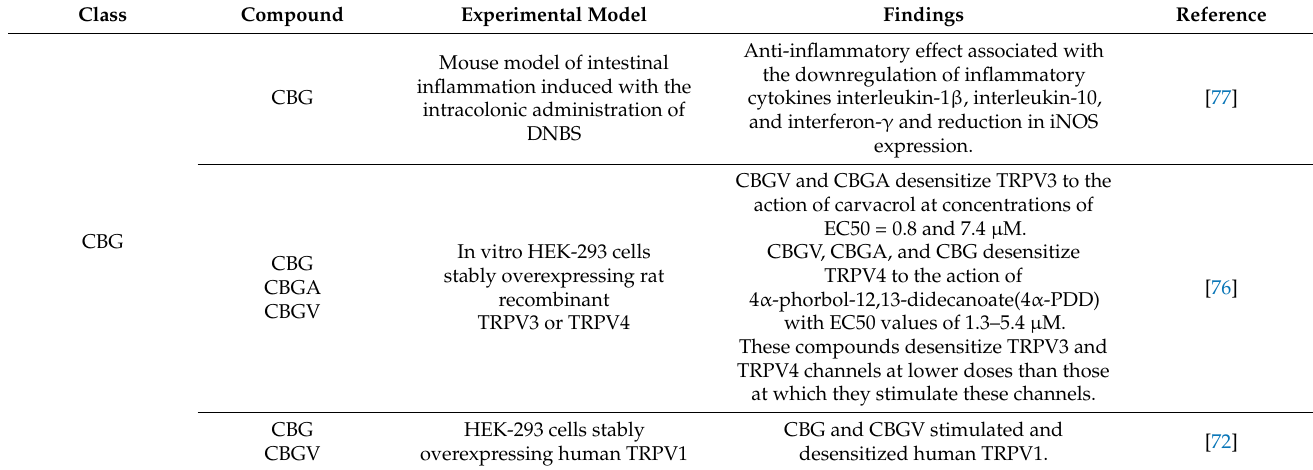
Table 3. The most important findings in preclinical studies on major cannabinoids and their related